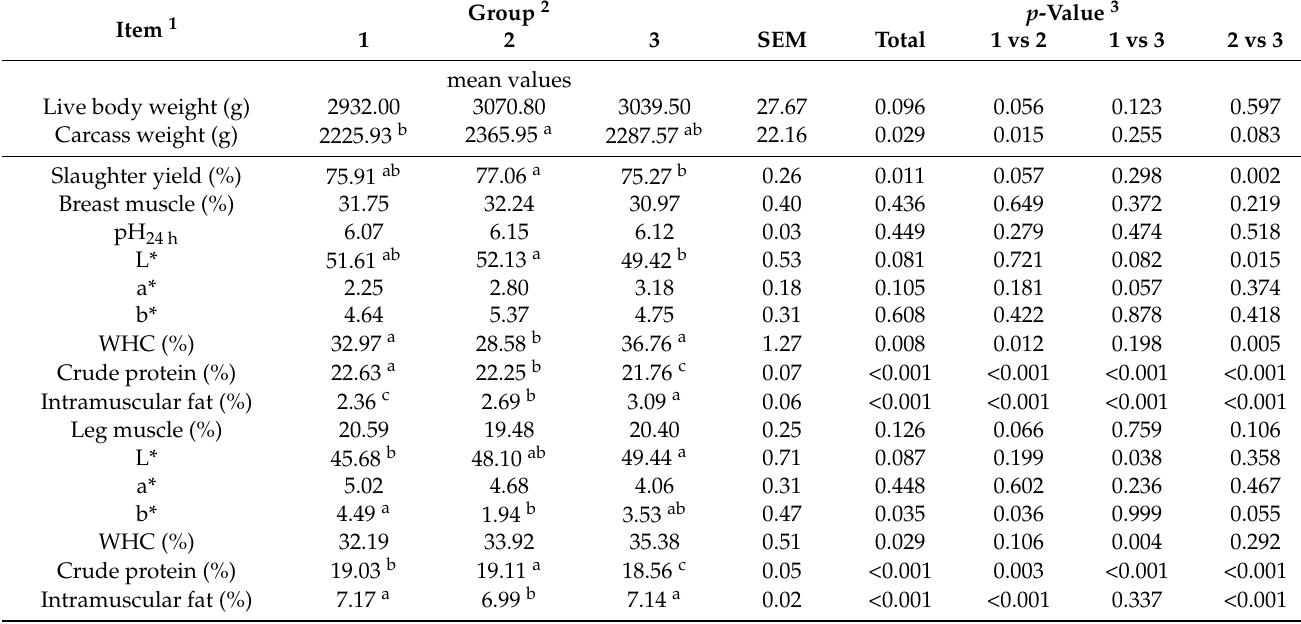
Table 4. Slaughter yield and quality traits of breast and leg muscles of chickens.